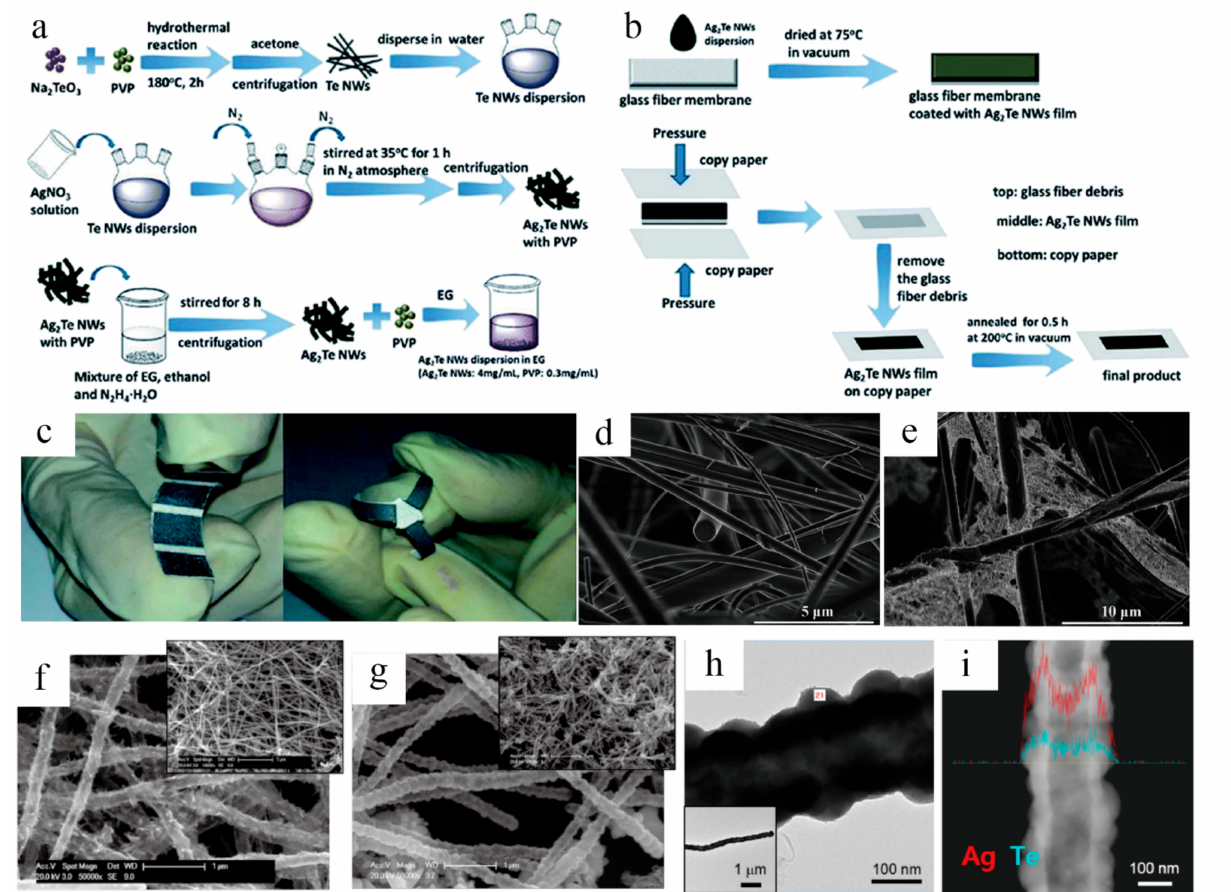
Figure 3. ( a ) Schematic diagram demonstrating Ag 2 Te nanowires and ( b ) the detailed process of fabricating paper coated with Ag 2 Te films. ( c ) One piece of paper constructed by four sheets of parallel (9 mm × 5 mm) Ag 2 Te nanowire films and a clover-like shape with three sheets (20 mm × 3 mm). ( d ) Representative SEM images of Ag 2 Te glass fiber sheet and ( e ) coated with Ag 2 Te nanowires dispersions. Reproduced with permission from Royal Society of Chemistry [41]. ( f – g ) High-definition SEM images of synthesized Ag x Te y hollow nanofibers; inserted are low-magnification pictures. ( h ) The TEM pictures and ( i ) line-scan EDS analysis of Ag x Te y nanofibers. Reproduced with permission [40]. Copyright 2015, American Chemical